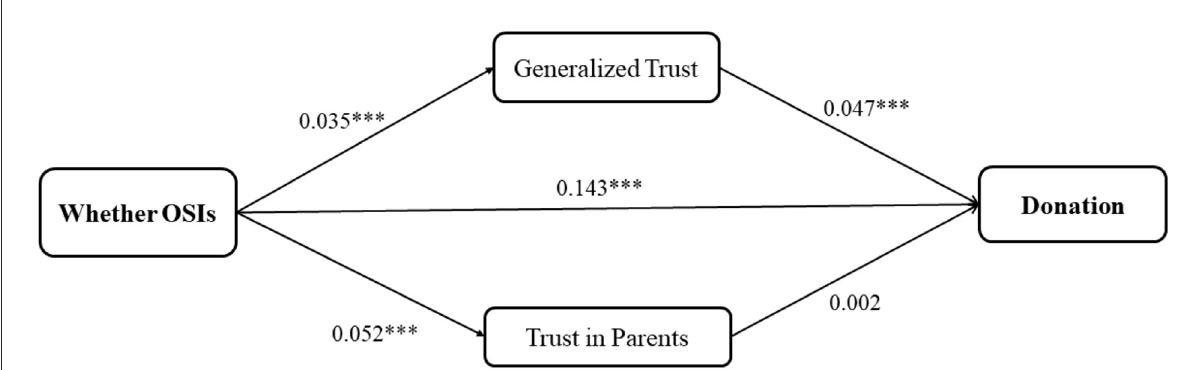
FIGURE1 Results of structural equation modeling showing the effect of OSIS on donation and mediating effects of trust. Note: Only important standardized coefficients are reported for brevity. All regressions include the series of covariates as table 3 and maximum likelihood are used